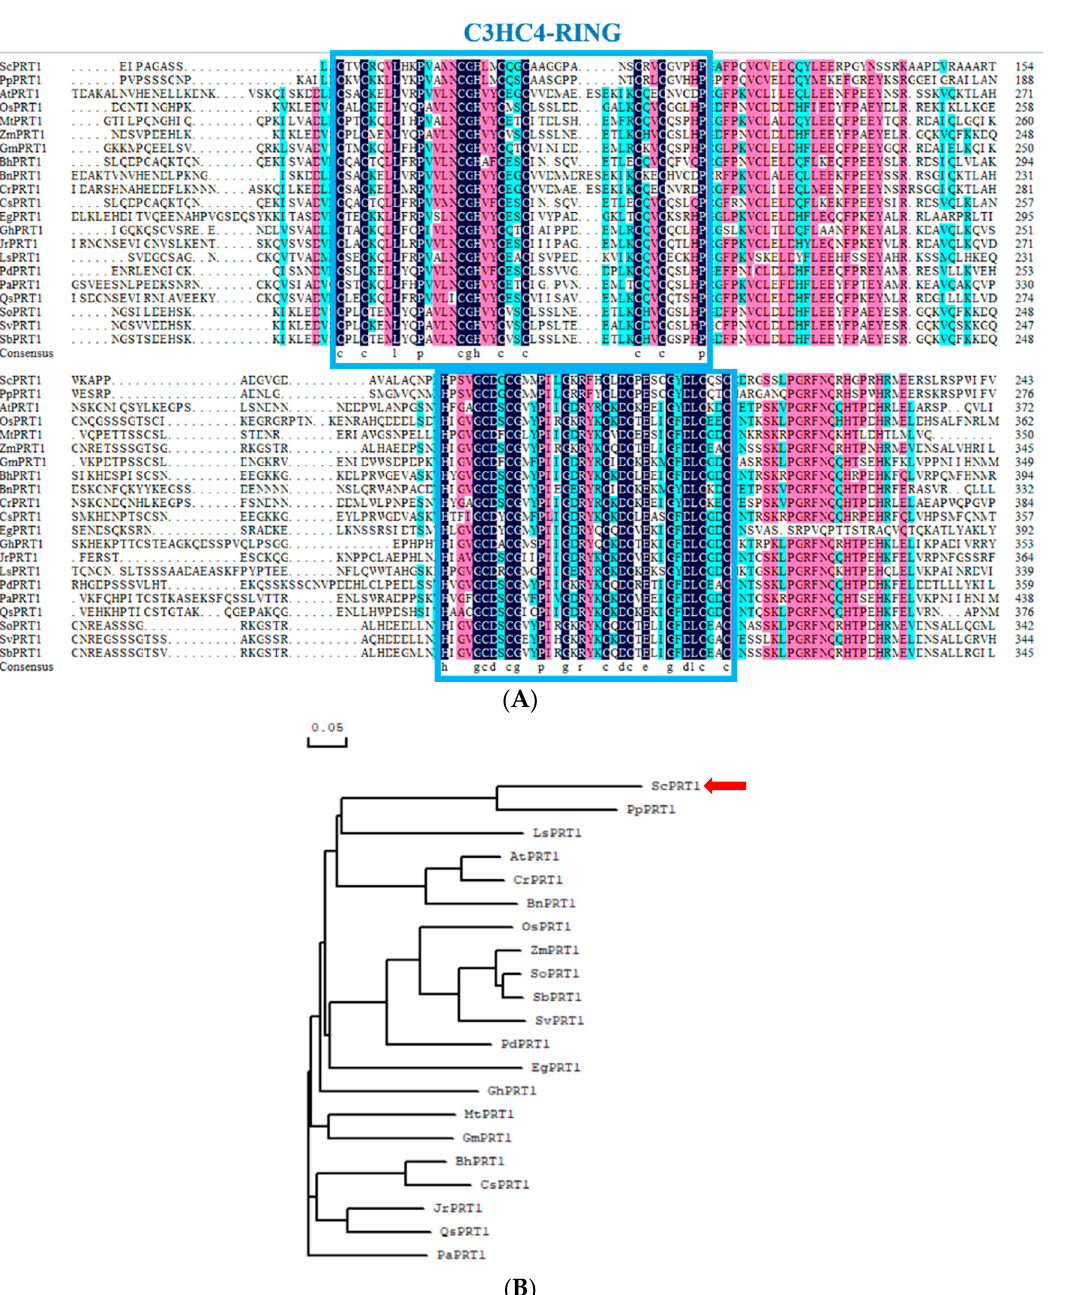
Figure 1. Multiple sequence alignment and phylogenetic analysis of ScPRT1. ( A ) Amino acid sequence alignment of ScPRT1 and closely related PRT1 from other plant species. ScPRT1 ( S. caninervis ), PpPRT1 ( P. patens , XM_024525392.1), AtPRT1 ( A. thaliana , AY080799.1), OsPRT1 ( Oryza sativa , XM_015767241.2), MtPRT1 ( Medicago truncatula , XM_003604918.4), ZmPRT1 ( Zea mays ,